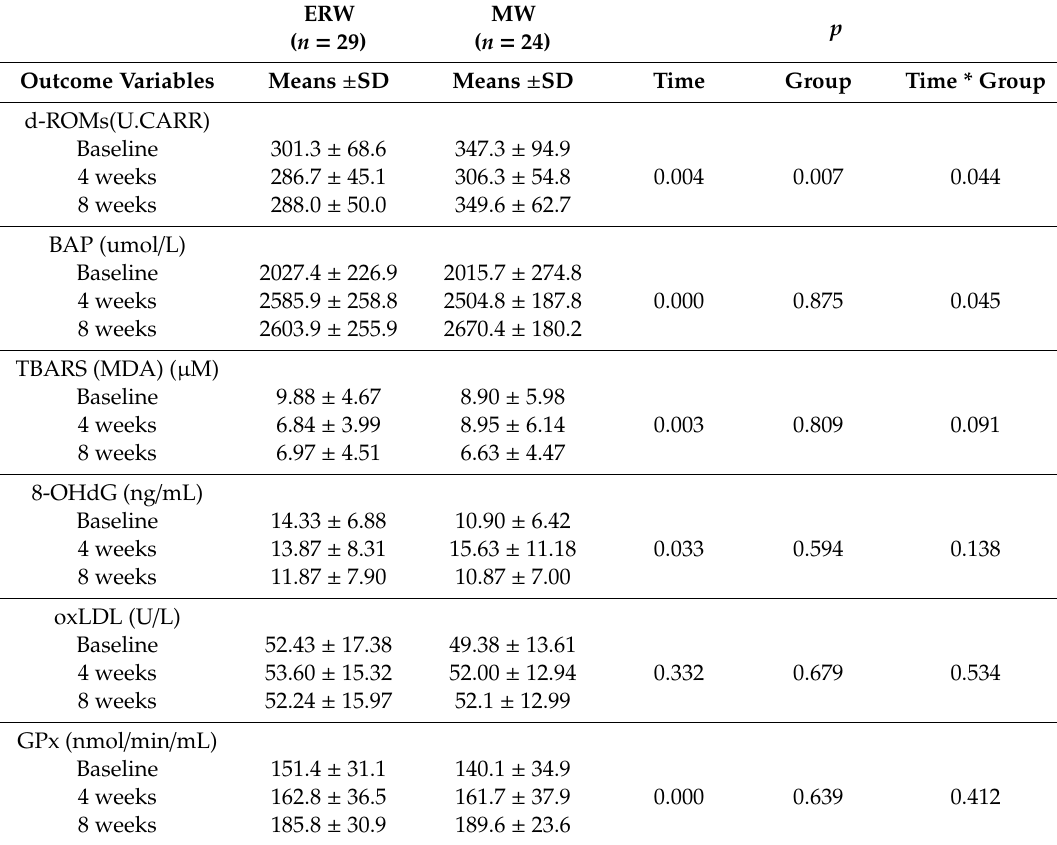
Table 2. E ff ect of treatment on the primary outcome variables: biomarkers of oxidative